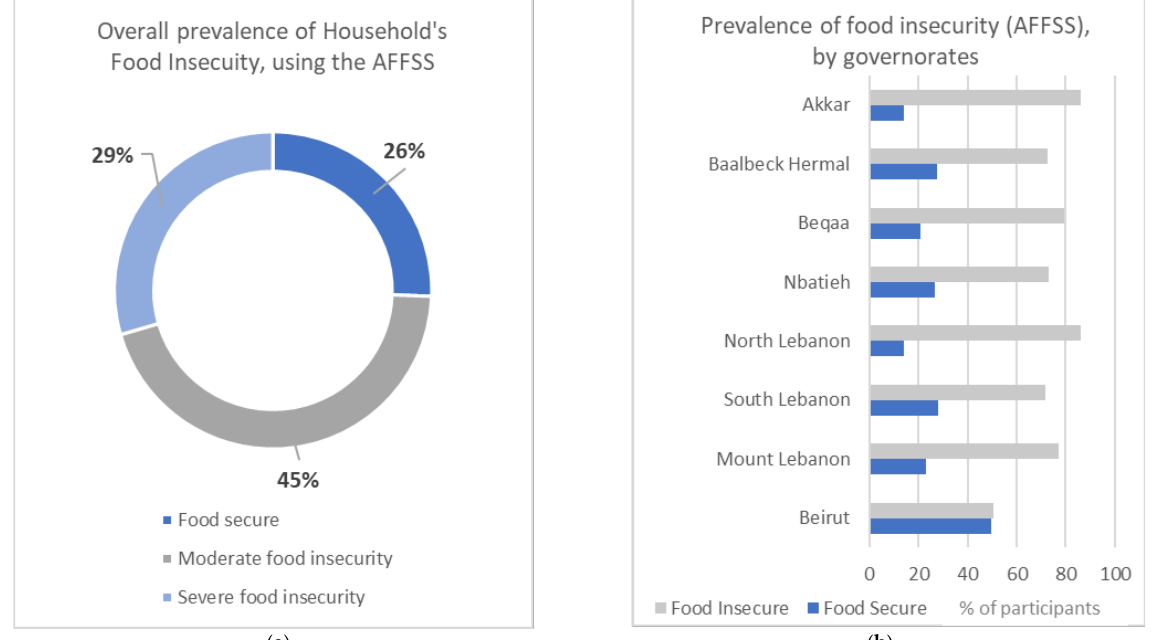
Figure 3. ( a ) Overall prevalence of household’s food insecurity. ( b ) Prevalence of household’s food insecurity, by governorate.